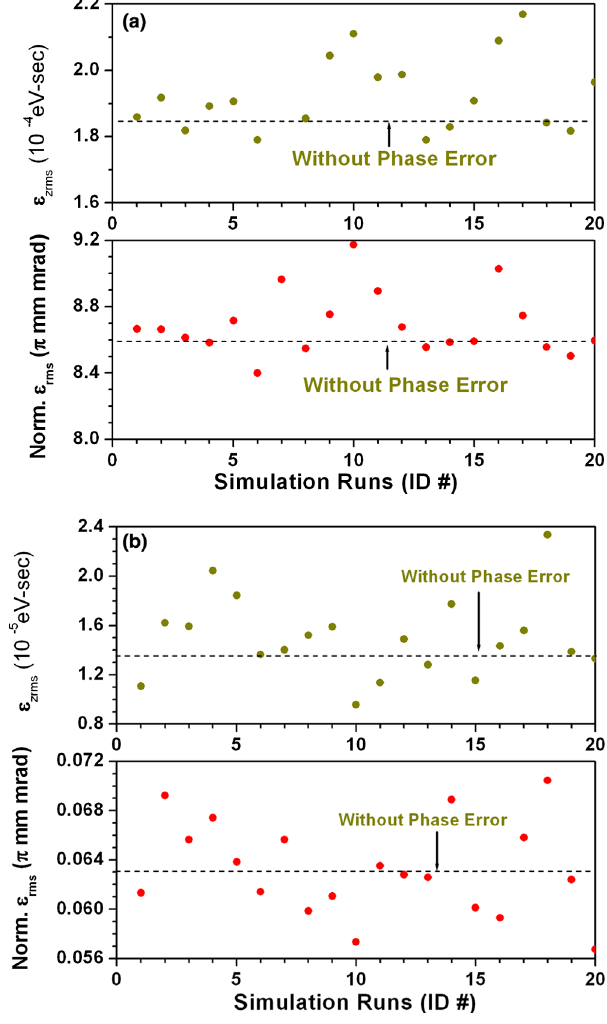
FIG. 14. Variation of longitudinal and transverse emittance with random phase error introduced in all the resonators over a range of (a) (cid:8) 0 : 3 deg with input longitudinal beam having phase width (cid:8) 10 deg , and (b) (cid:8) 1 deg with input longitudinal beam having phase width (cid:8) 5 deg